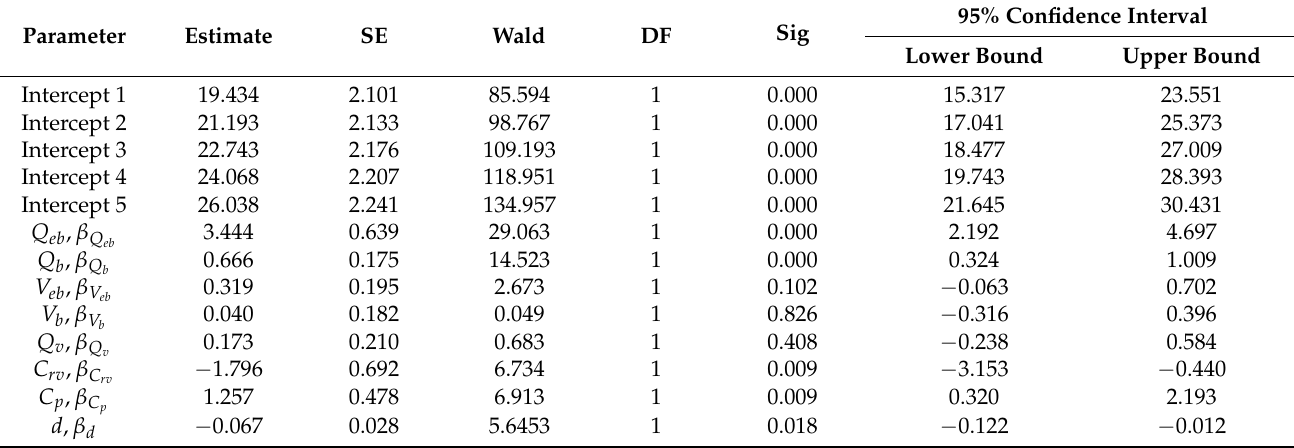
Table 7. Maximum Likelihood Estimates for LOS